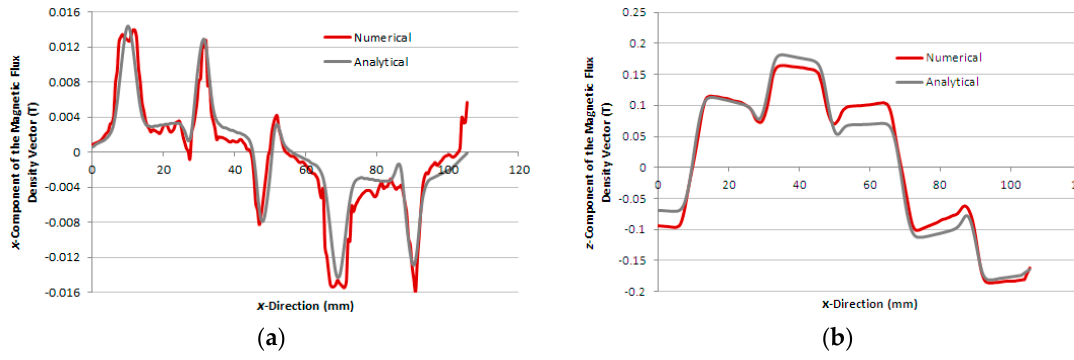
Figure 8. Components of the magnetic flux density vector as a function of x -direction, case 3: ( a ) x -component and ( b ) z -component.